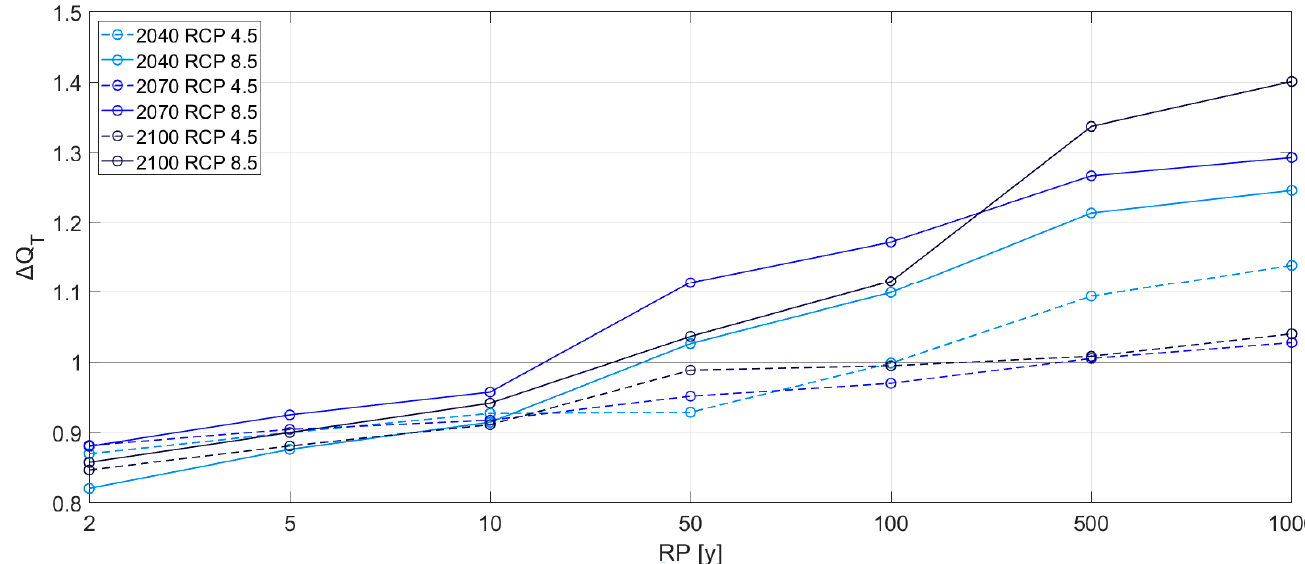
Figure 9. Median values of expected flood changes in the three time windows and two emission scenarios.